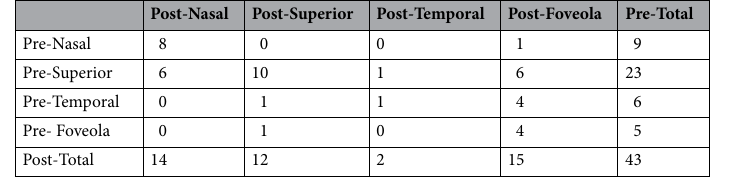
Table 3. Distribution of fixation locations before and after